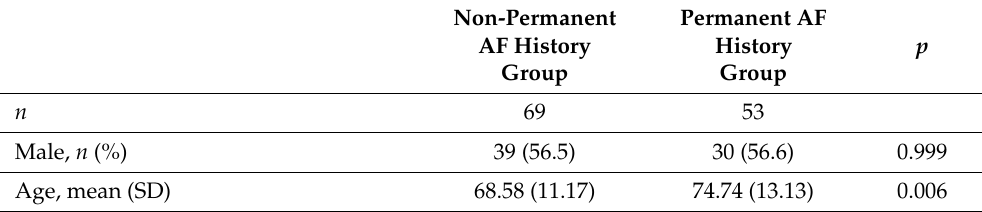
Table 2. Characteristics and differences between the two groups according to history of non- permanent or permanent